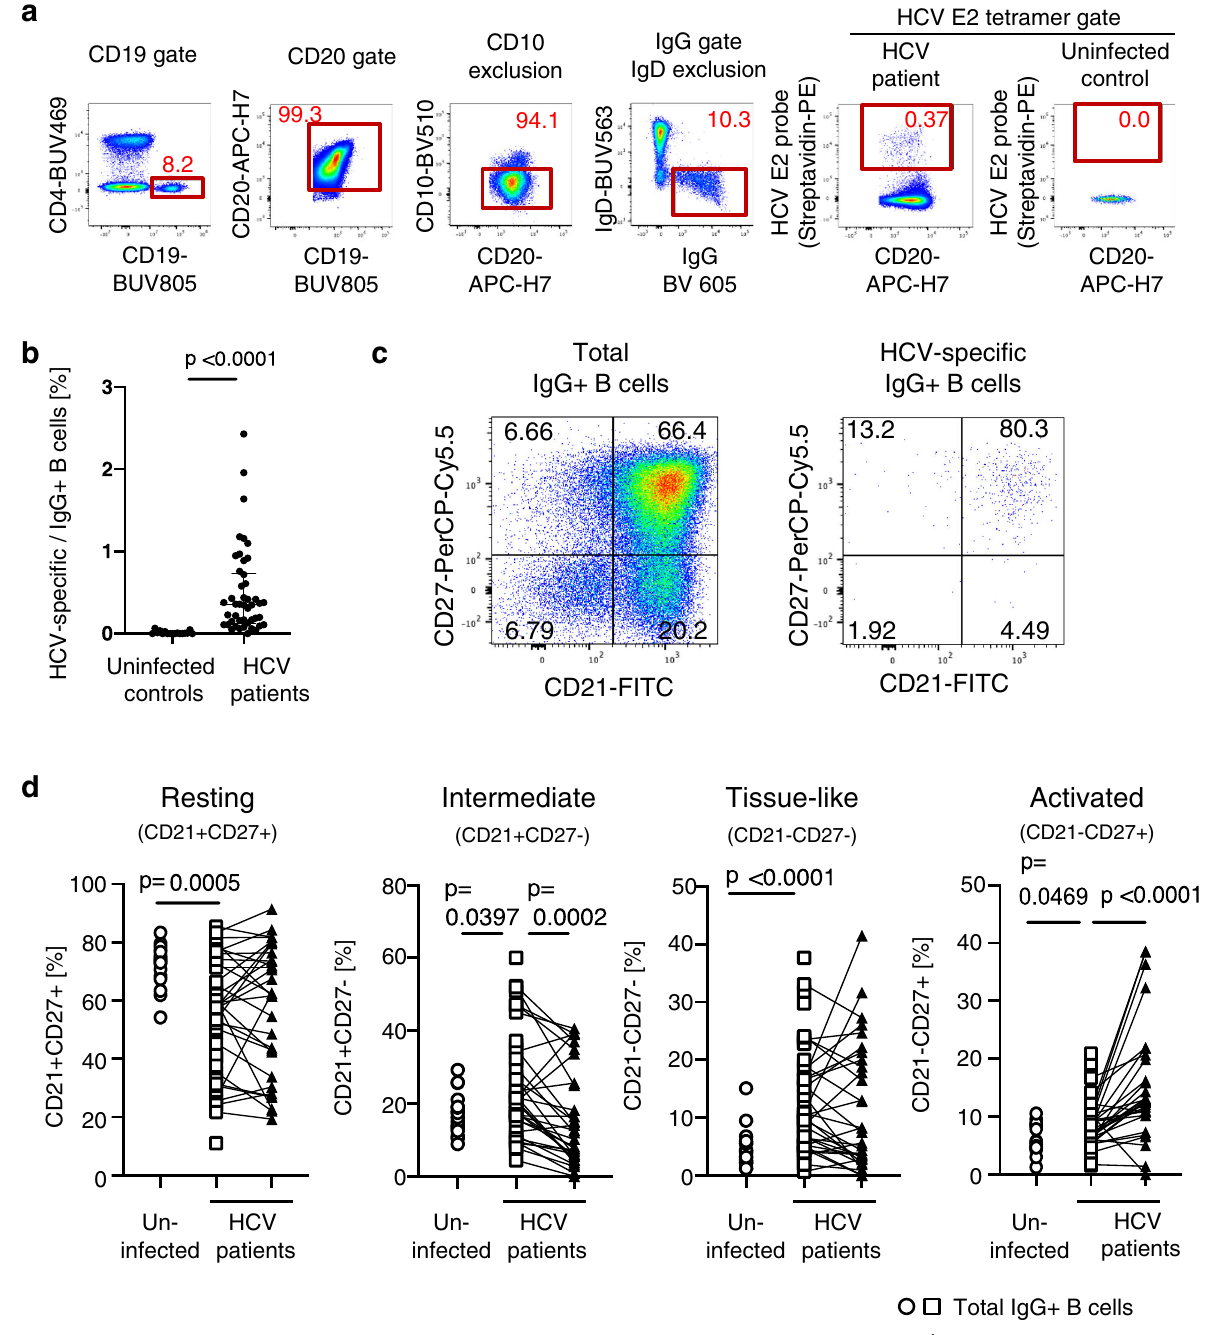
Fig.4|DifferentialphenotypeofHCV-speci fi candtotalmemoryBcellsinHCV- infectedpatientsanduninfectedcontrols.a Representative fl owcytometryplots illustrating the gating strategy to identify HCV envelope 2 (E2)-speci fi c memory B cells. b FrequencyofHCV-speci fi cBcellsinthebloodofpatientswithchronicHCV infection ( n =48) and uninfected controls ( n =17). Each data point represents one studyparticipant;median+IQRareshown.Two-sided p valueswerecalculatedwith theMann – Whitney U -test. c Representative fl owcytometryplotsillustrating